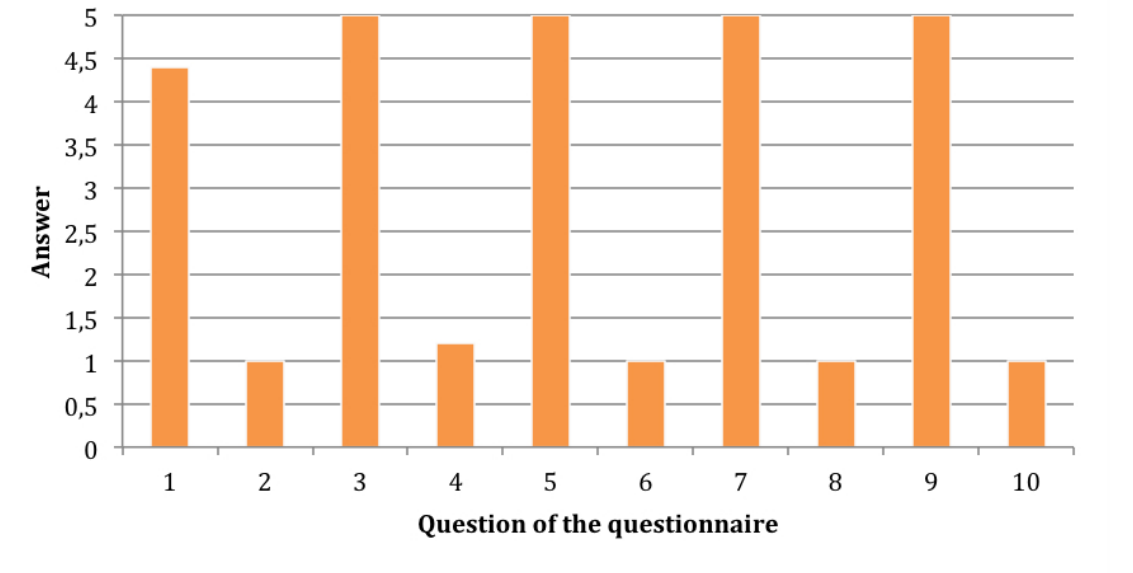
Figure 9. System Usability Scale (SUS)